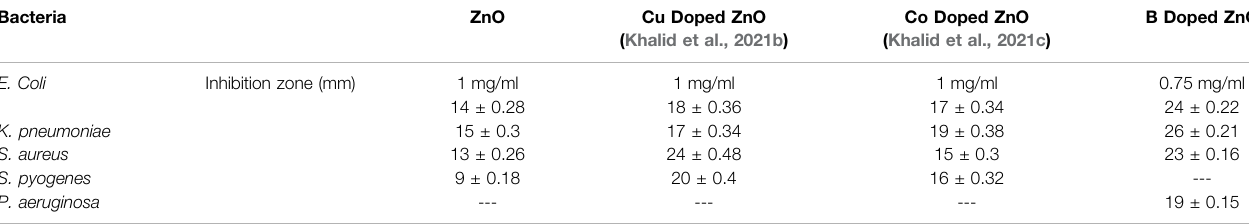
TABLE 2 | Antibacterial ef fi ciency of B-doped ZnO-NSs in comparison with pure, Cu-doped, and Co-doped ZnO. Bacteria ZnO Cu Doped ZnO